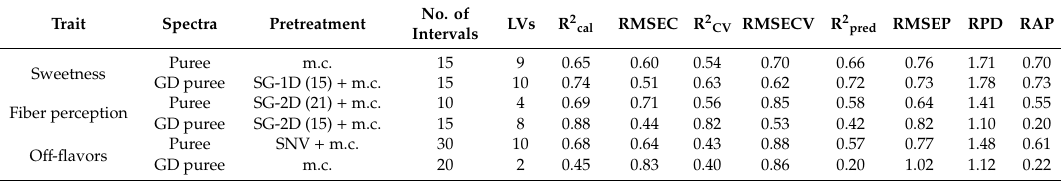
Table 3. Statistical descriptors for NIRS determinations using interval partial least squares (iPLS) variable selection.